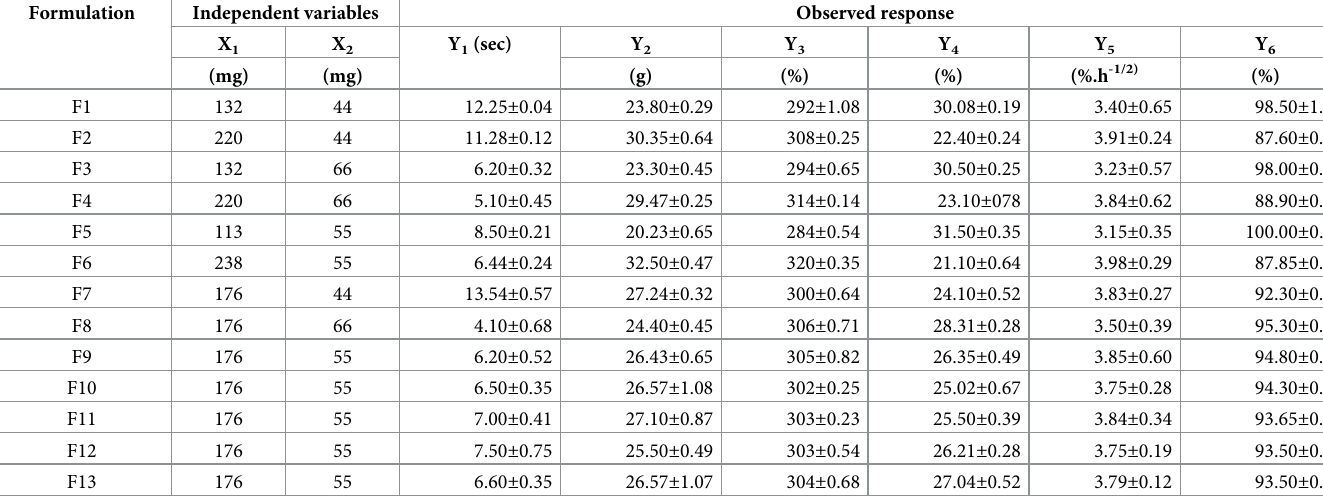
Table 4. Formulations of ranitidine HCl (150 mg) matrix tablets with the levels of independent variables and observed values for the response variables.